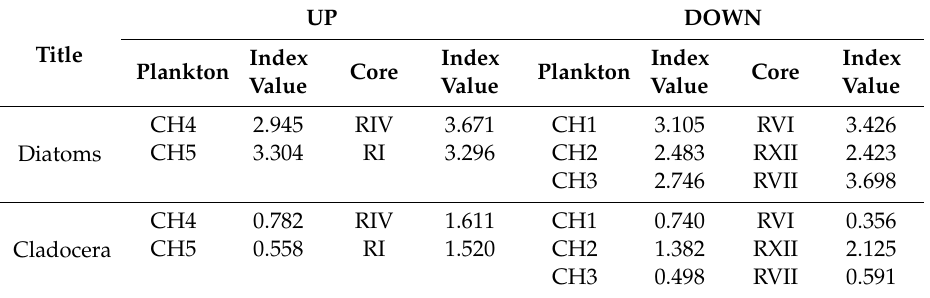
Table 4. Shannon (H ′ ) diversity index value in investigated plankton samples and sediment cores. (UP-subsidence pond formed after mine was closed; DOWN-subsidence ponds formed during the peak of Zn and Pb ore exploitation).